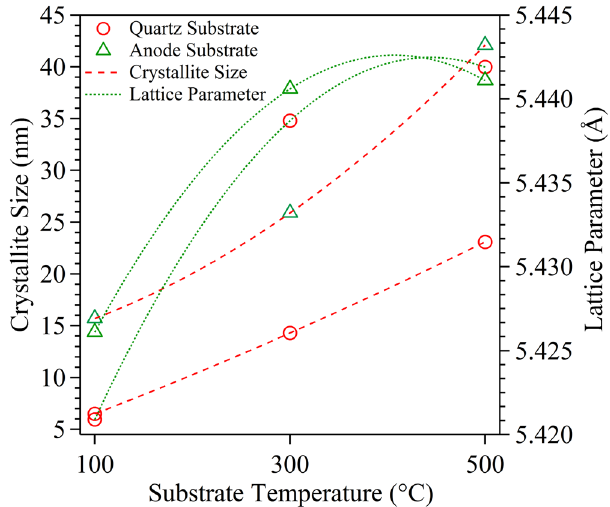
Figure 3. Calculated crystallite size using Scherrer equation for thin film with respect to substrate temperature deposited on quartz and